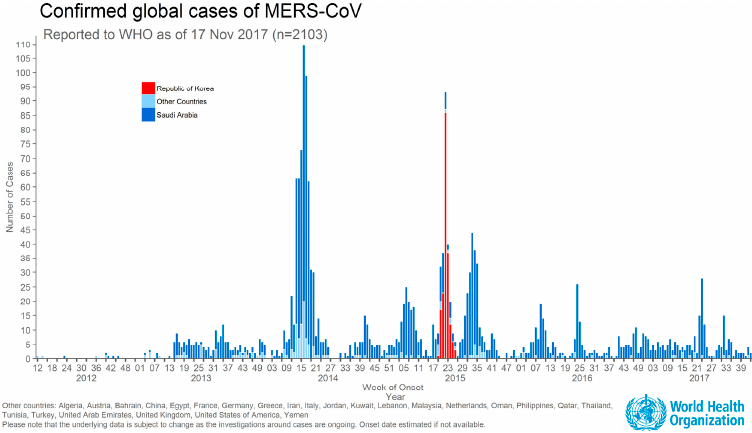
Figure 1. Confirmed global cases of MERS-CoV (source: https://www.who.int/emergencies/mers-